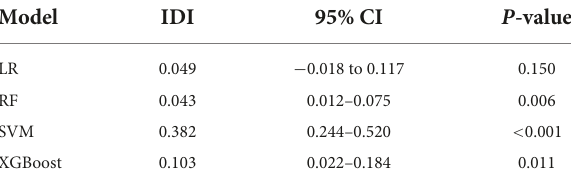
TABLE 4 Improvement index before and after feature